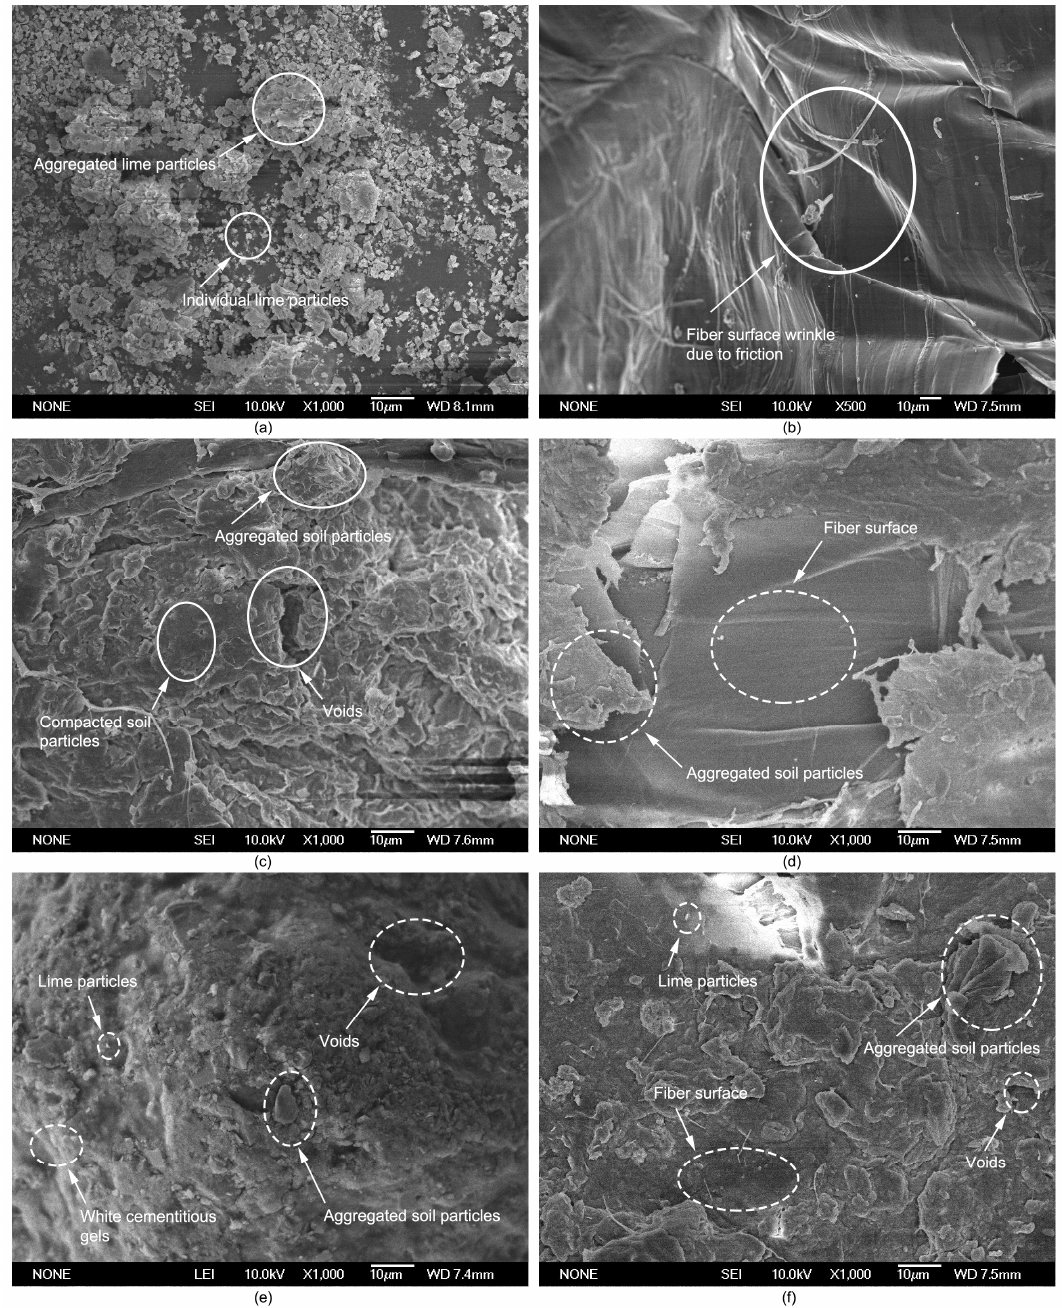
Figure 8. SEM micrographs showing ( a ) lime; ( b ) a fiber surface wrinkle; ( c ) untreated soil; ( d ) the fiber surface morphology in 0.4% fiber-reinforced soil; ( e ) the soil particle morphology in 4% lime-stabilized soil; and ( f ) the fiber surface morphology in 0.4% fiber-reinforced soil stabilized with 4% lime.